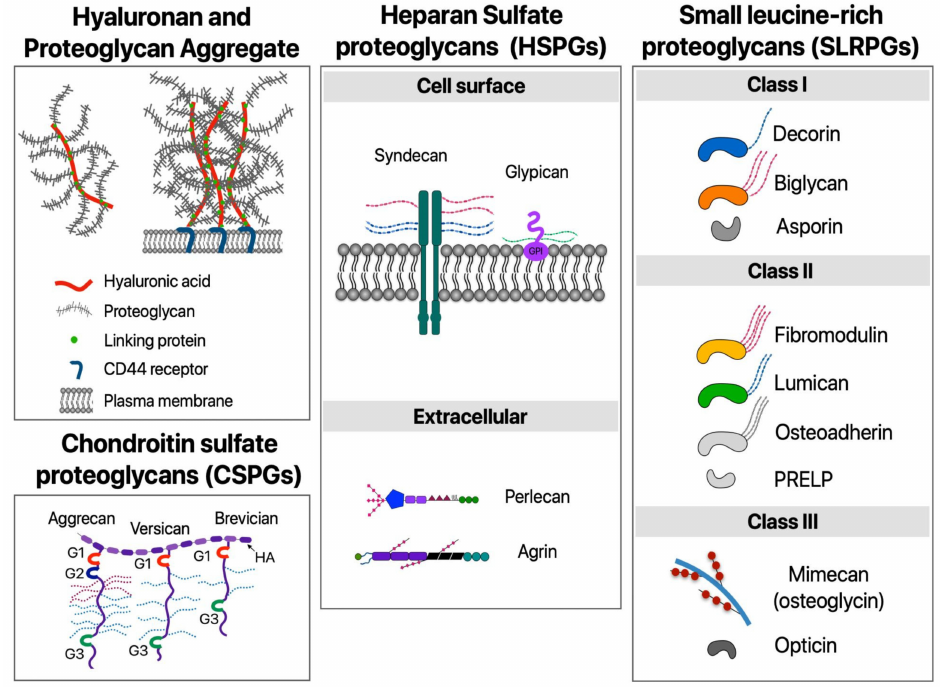
Figure 2. Simplified schematic of main proteoglycans found in the ECM. G1, G2, G3: Globular domains. HA: Hyaluronic acid. PRELP: proline/arginine-rich end leucine-rich repeat